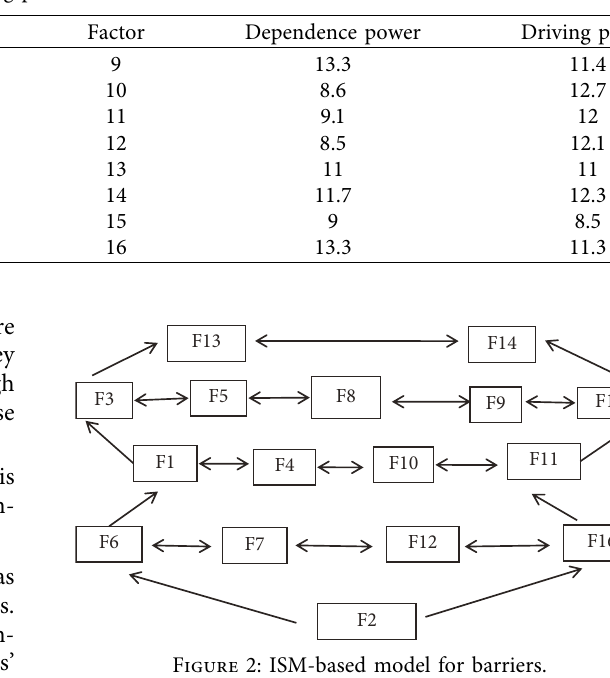
Table 5: Dependence power and driving power for factors based on stabilized FDRM.